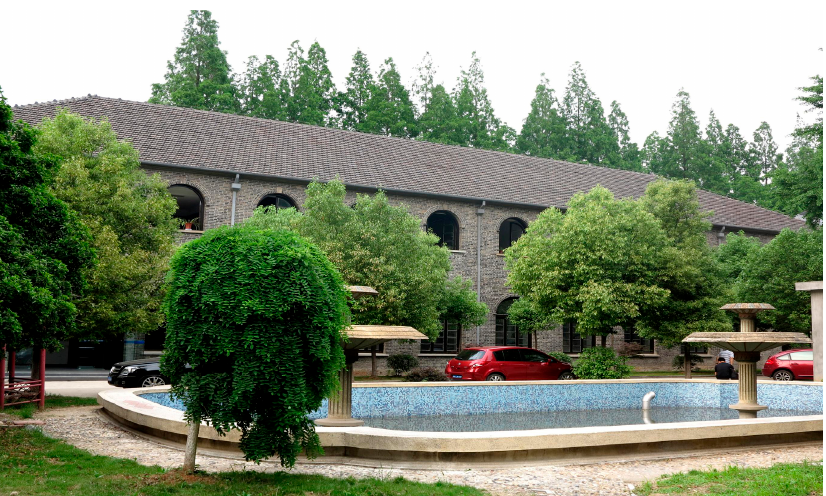
Figure 19. The surroundings after restoration. Pictures by Y.W.